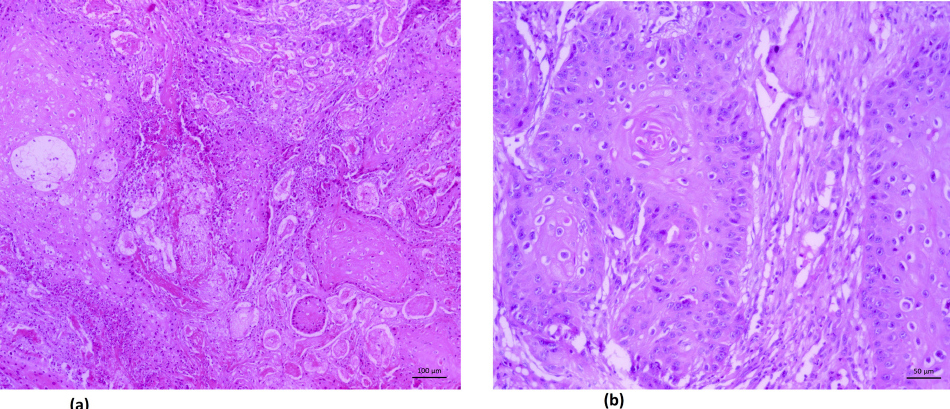
estroma fibroso. Notar o carácter infiltrativo, bem como focos de necrose e intenso infiltrado inflamatório